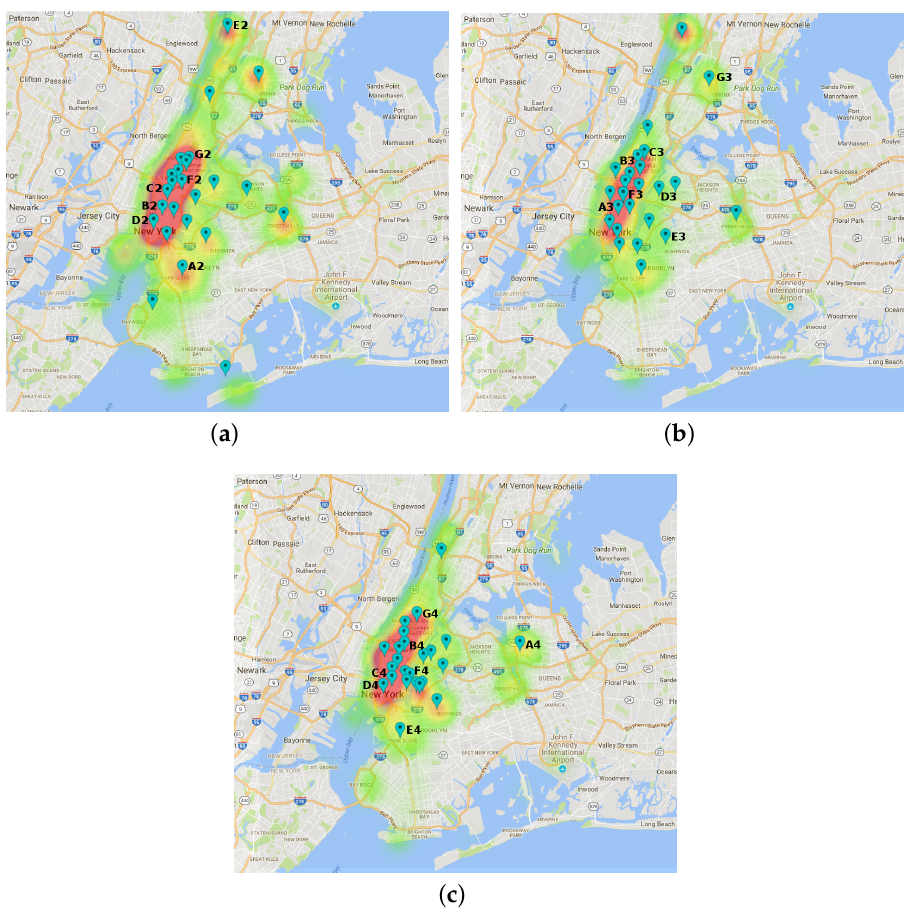
Figure 8. Centroids for NY dataset depicted as pins. The labelled ones are further discussed later. ( a ) morning slot (2); ( b ) afternoon slot (3); ( c ) evening slot